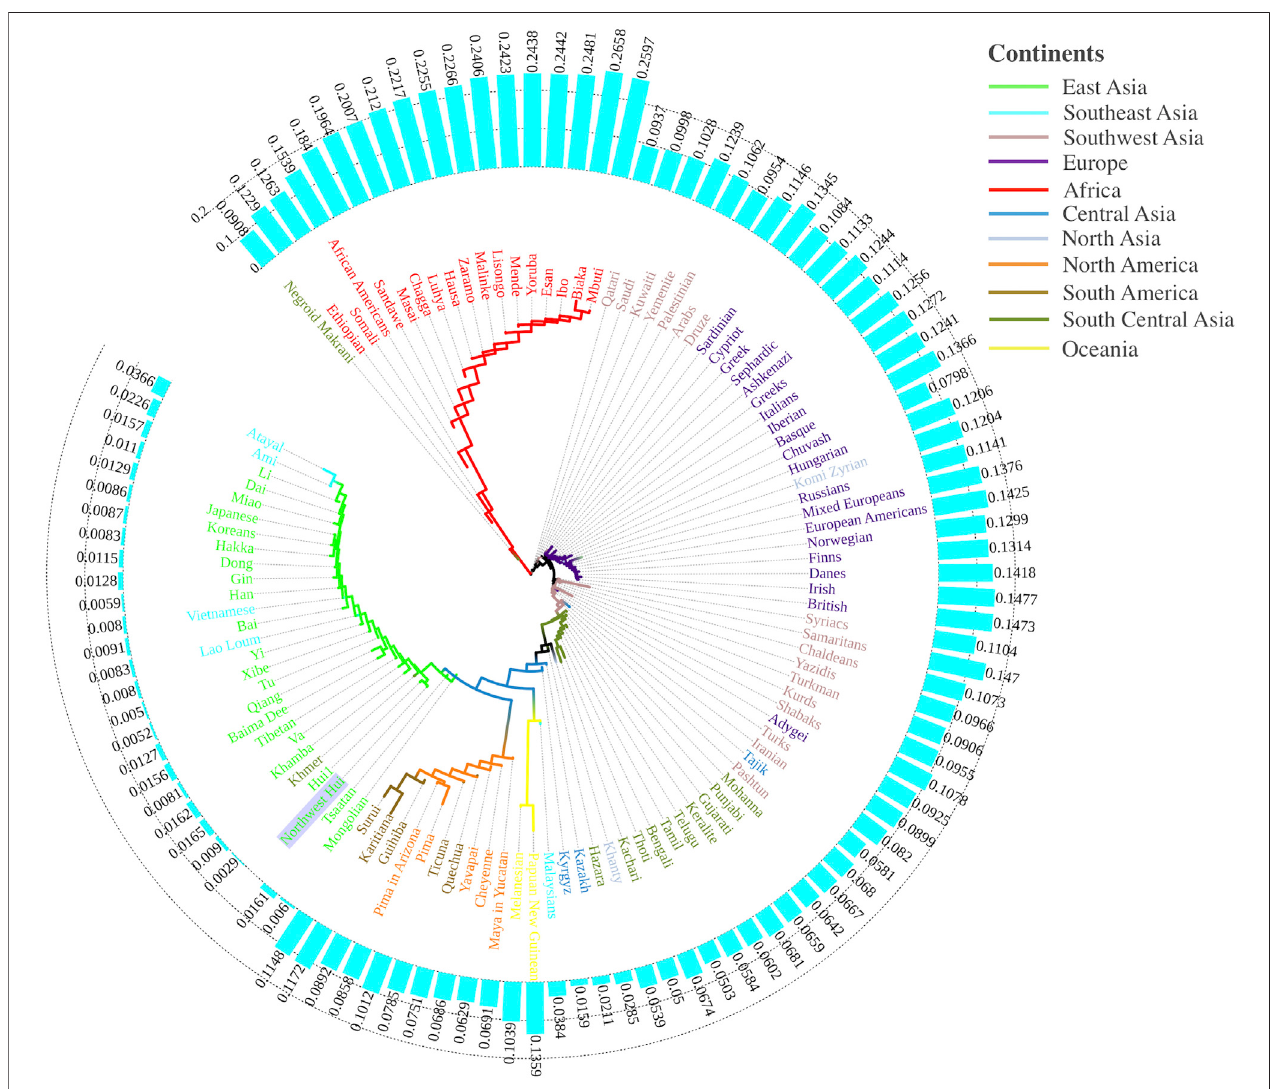
FIGURE10| Aneighbor-joiningtreeconductedbasedonNei ’ s D A valuesfortheNorthwestHuigroupand109referencepopulations.Ahistogramofthe D A values between the Northwest Hui group and the reference populations distributed around the phylogenetic tree.